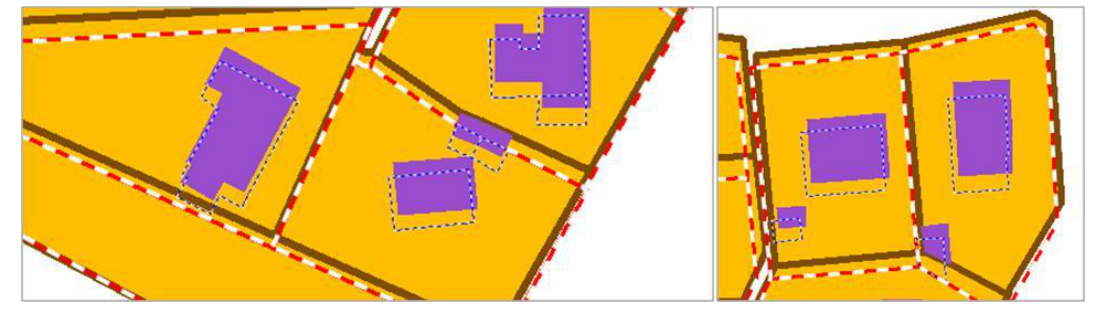
Figure 20. Other examples of propagated buildings, including buildings topologically connected to conflated parcels.